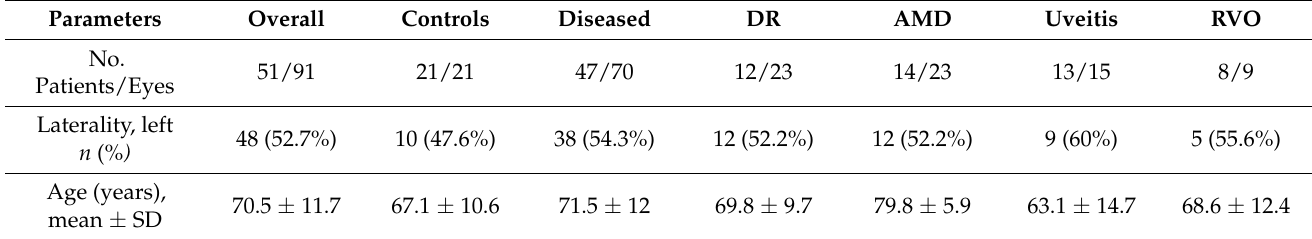
Table 1. Demographic and main clinical data of study